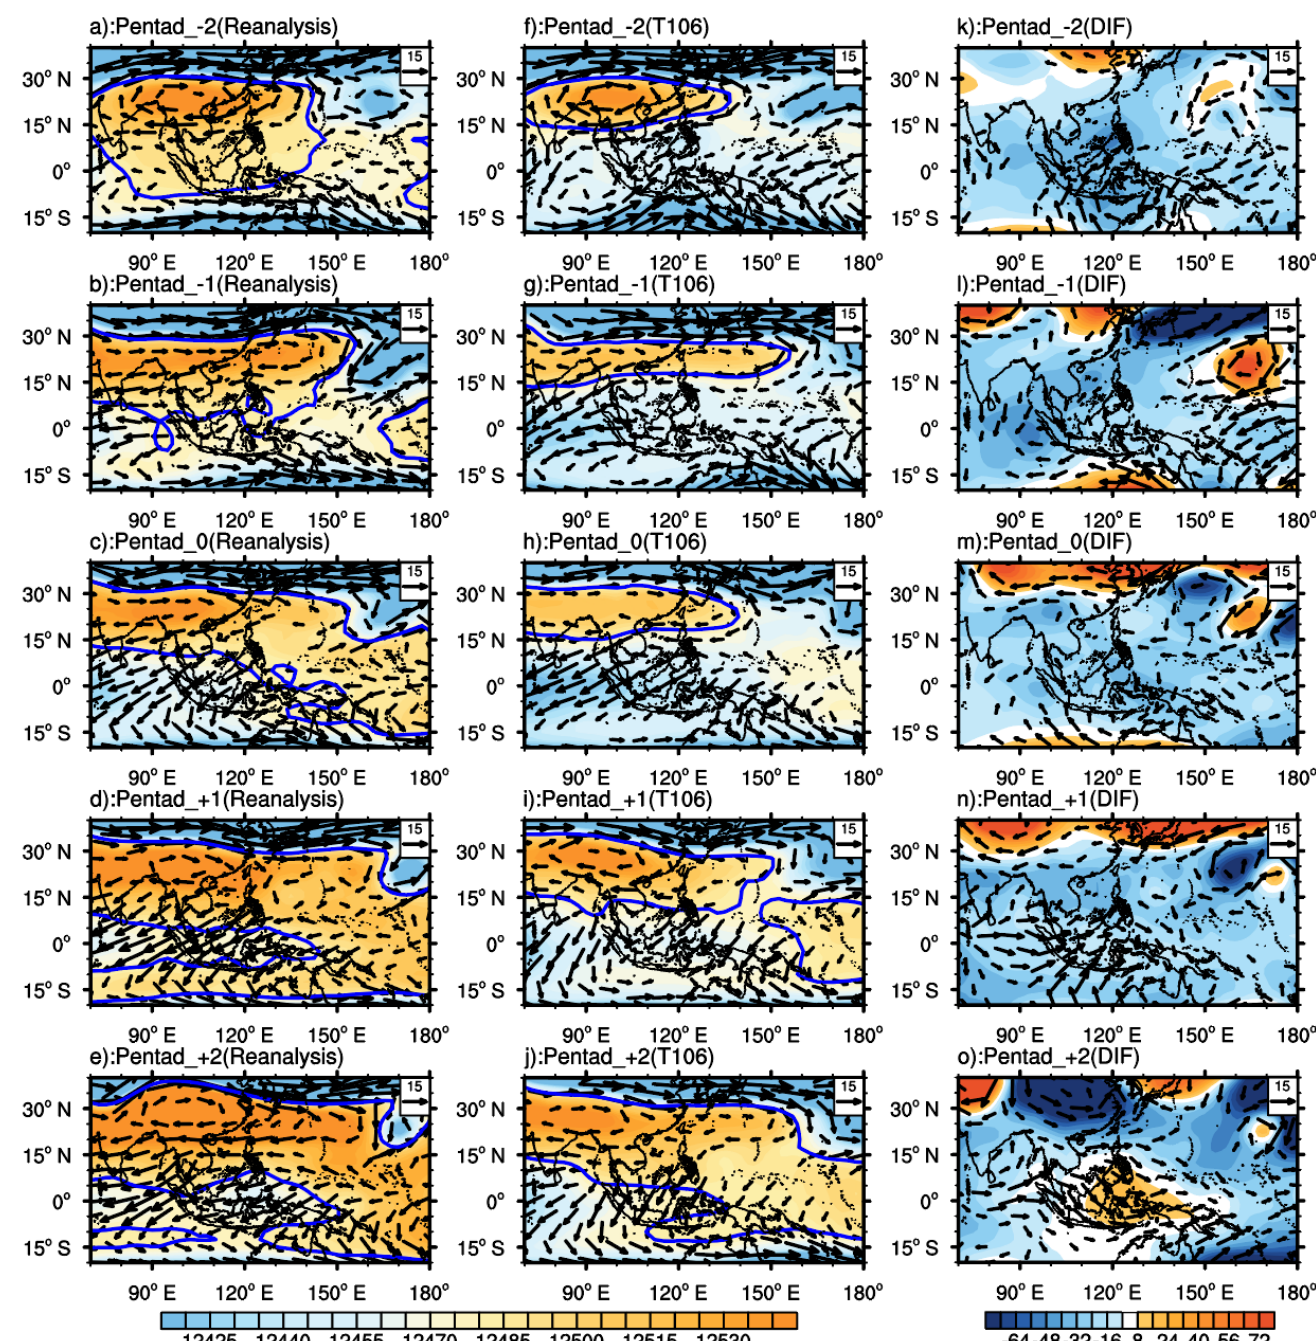
Figure 12. Same as Figure 11, but for T106 × T255 forecasts. ( a − e ): reanalysis; ( f − j ): prediction; ( k − o ): difference between predictions and reanalysis.